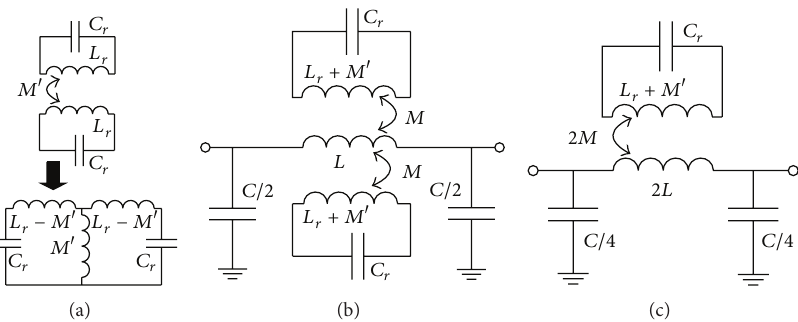
Figure 11: Equivalent T-circuit model of a pair of magnetically coupled inductors (a), circuit model of the structure of Figure 10(a) with the inductive coupling between resonators transformed to the equivalent T-model (b), and circuit that results by applying the magnetic wall concept (c). From [43], reprinted with permission.